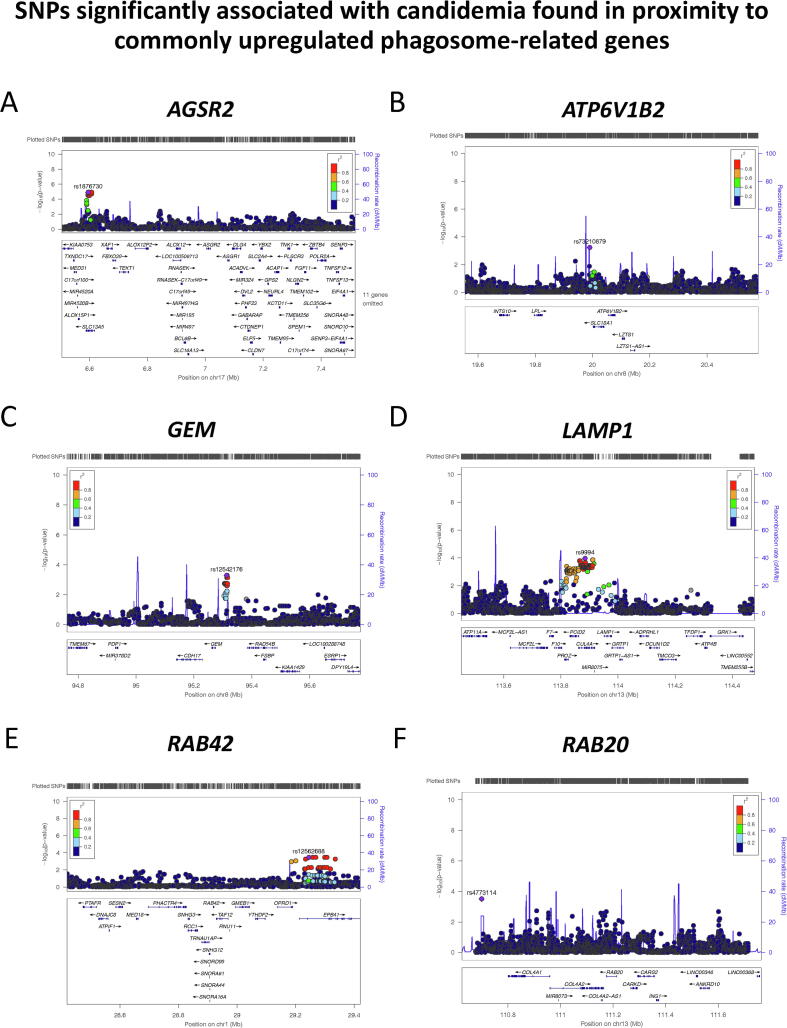
Differentially expressed genes in response to the three fungi are found to be located in candidemia-associated loci (p < 0.0006); related to Table 1. Genetic association study in candidemia patient to validate the importance of phagocytosis-associated genes that were differentially regulated in PBMCs of healthy volunteers. (A) Regional association plot of candidemia-associated rs1876730, in close proximity to AGSR2 gene on chromosome 17. (B) Regional association plot for candidemia-associated SNP rs73210879, which was mapped in a window of 1 MB around ATP6V1B2 gene on chromosome 8. (C) Regional association plot for candidemia-associated SNP rs12542176, in close proximity to GEM gene on chromosome 8. (D) Regional association plot for candidemia-associated SNP rs9994, in close proximity to LAMP1 gene on chromosome 13. (E) Regional association plot for candidemia-associated SNP rs12562688, in close proximity to RAB42 gene on chromosome 1. SNPs are plotted as the -Log of the p-value. (F) Regional association plot for candidemia-associated SNP rs4773114, which was mapped in a window of 1 MB around RAB20 gene on chromosome 13. Local linkage disequilibrium (LD) structure is reflected by the plotted estimated recombination rates (from HapMap) in the region around the associated SNP (purple diamond) and its correlation proxies. The correlation of the lead SNP to other SNPs at the locus is indicated by color. (For interpretation of the references to color in this figure legend, the reader is referred to the web version of this article.)